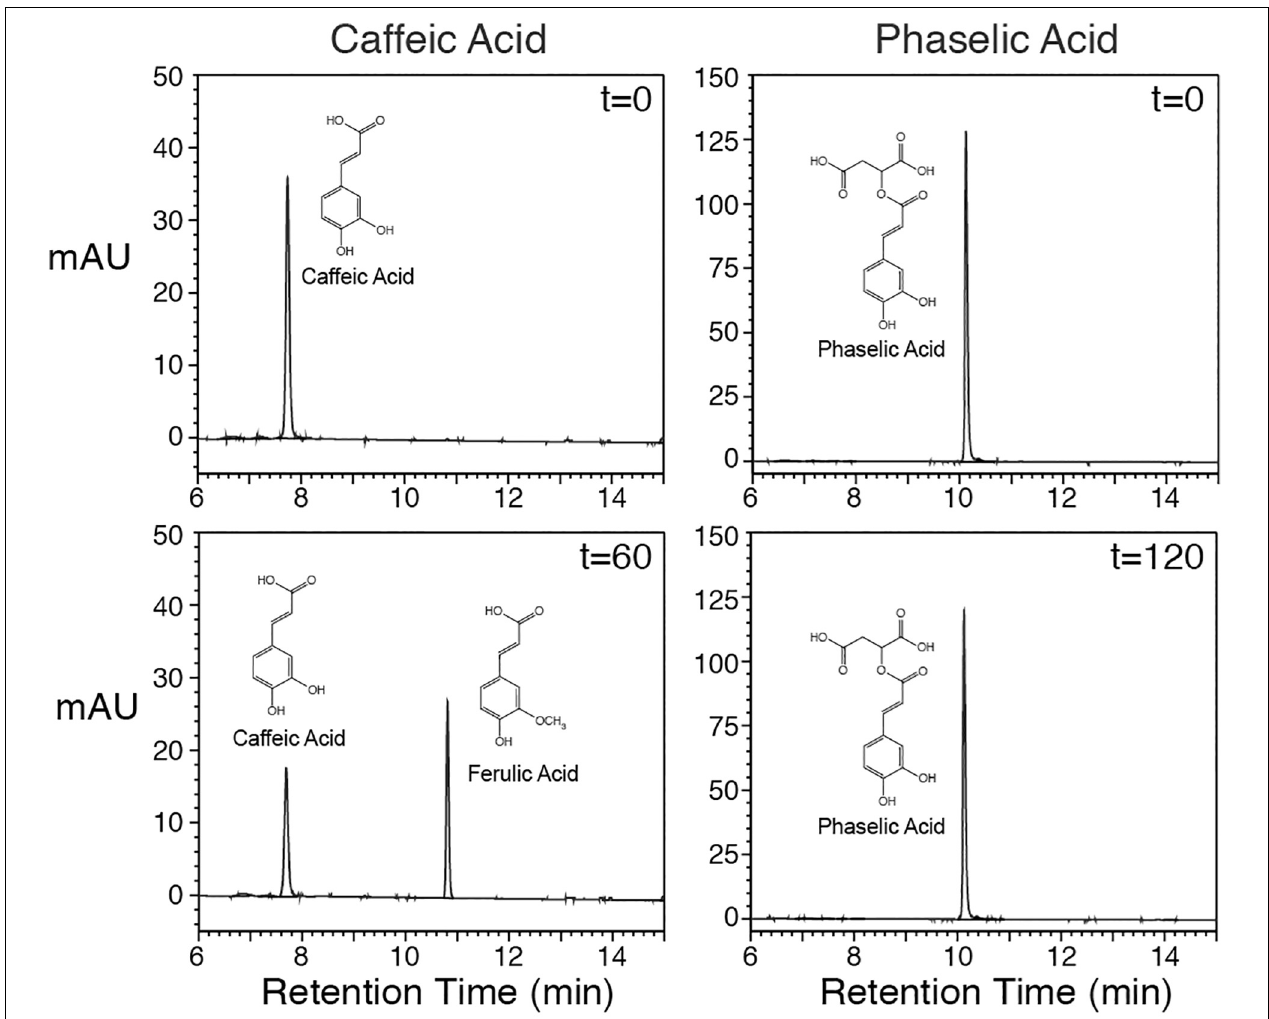
FIGURE 4 | Alfalfa COMT protein, produced in E. coli , was incubated with caffeic acid (left panels) or caffeoyl-malate (right panels) for up to 120 min as indicated, and reactions were resolved by reverse phase LC with PDA detection (250–500 nm). Reactants and products are labeled. No methylation product was detected when caffeoyl-malate was used as